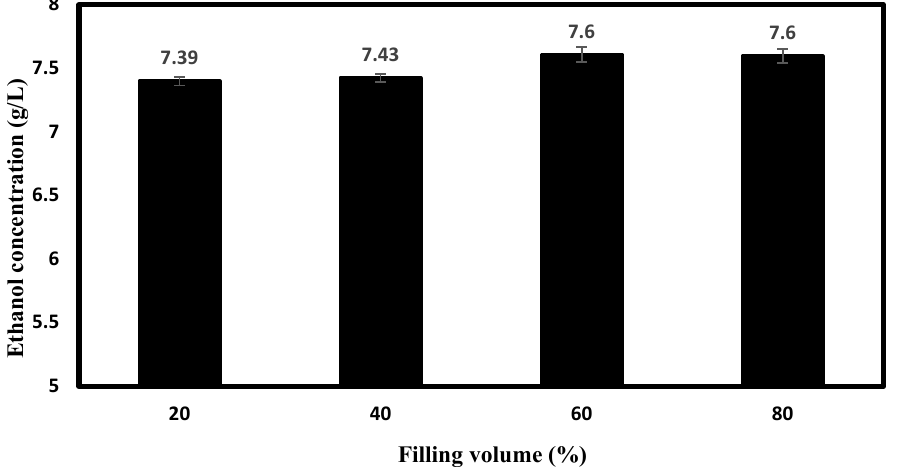
Figure 6. Effect of volume of fermentation medium on ethanol production from chitin oligomer by M. circinelloides.